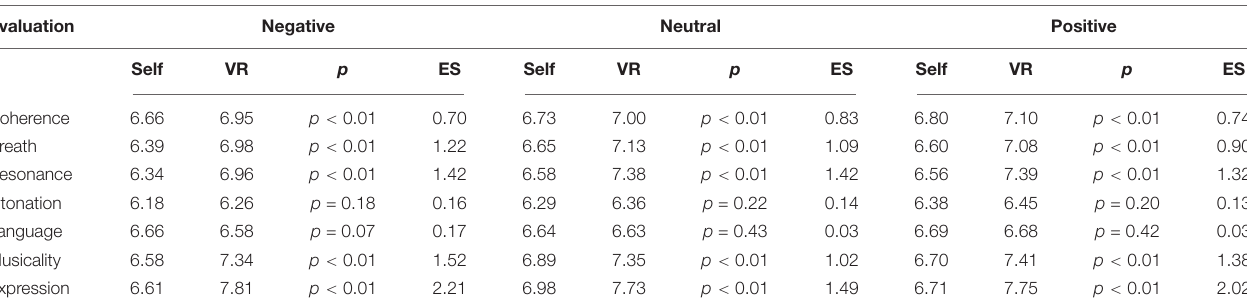
TABLE 4 | Average score of the subjects and the statistical test results of the third-party evaluation.